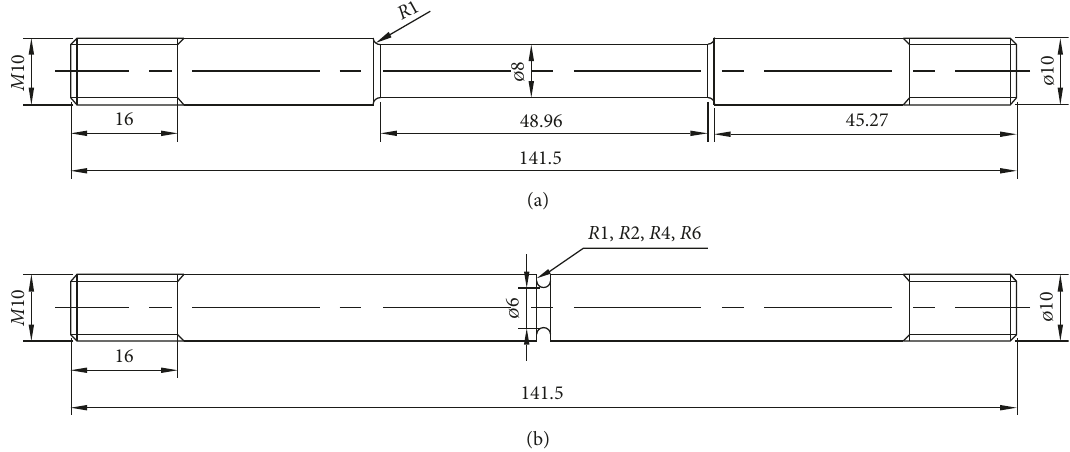
Figure 2: Scheme of the tensile sample (all dimensions are in mm): (a) uniaxial high-temperature tensile; (b) notch high-temperature tensile.